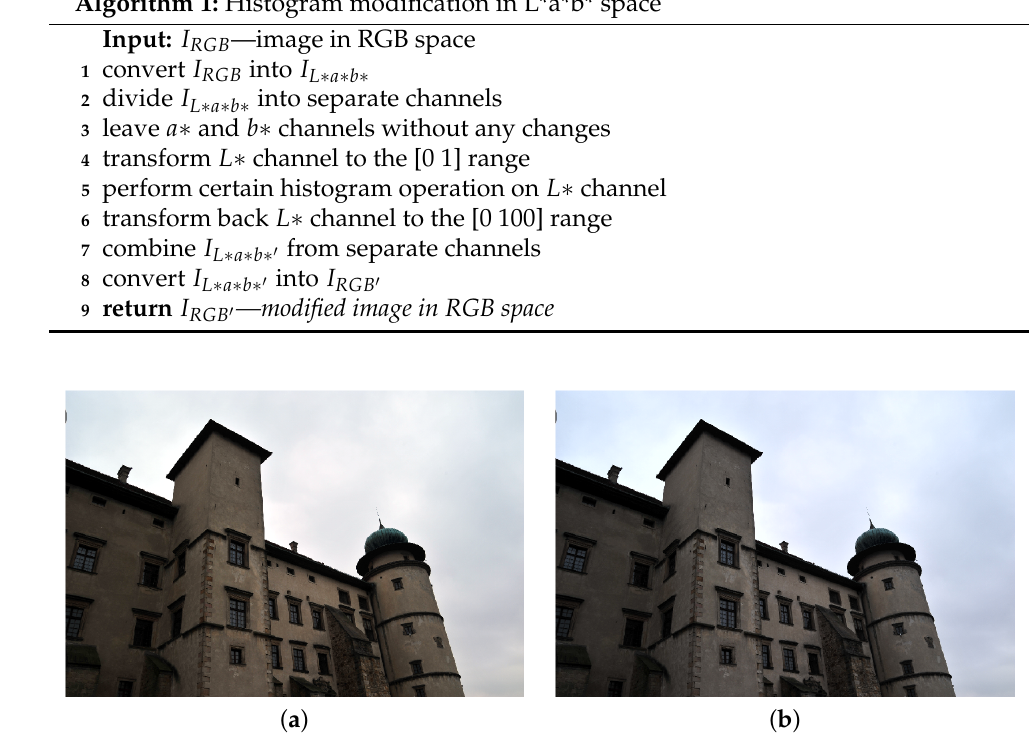
Figure 3. Image transformed with the use of histogram stretching in RGB ( a ) and L*a*b* space ( b ).